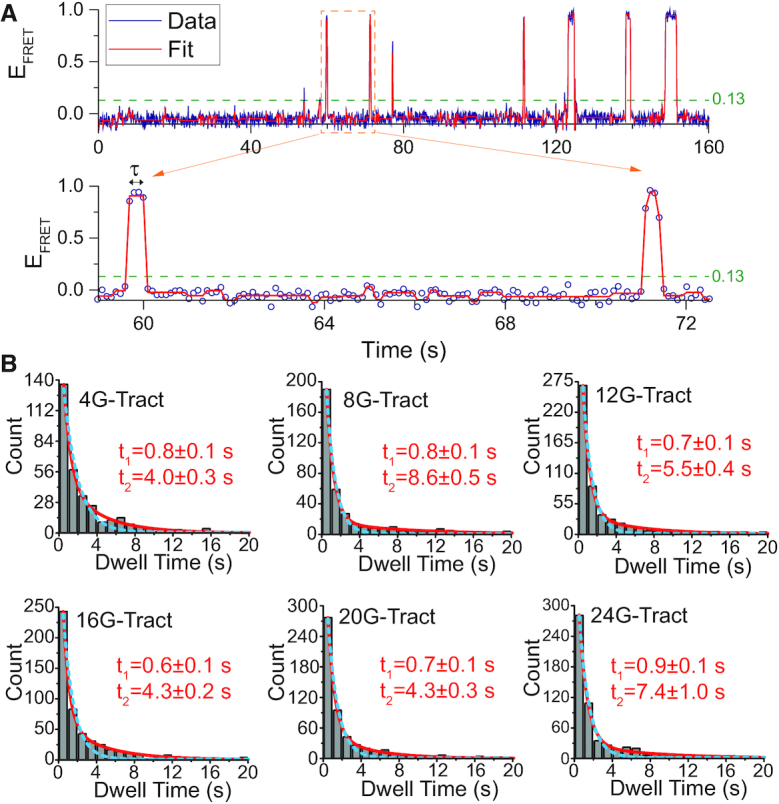
Determining the characteristic dwell times. (A) An example smFRET time trace that shows seven PNA binding events to a single telomeric overhang. A Stepfinder fit (red line) is used to characterize the FRET levels and dwell times (τ) of the binding events. The dashed line at EFRET = 0.13 represents the threshold level used for considering a FRET burst a PNA binding event, rather than noise. The signal bursts should also satisfy τ≥300 ms to be considered a binding event. (B) Distribution of dwell times determined from Stepfinder fit for each construct. The distributions were better described with a double exponential (red line) fit compared to a single exponential (dashed cyan line) fit, which consistently underestimated the counts of events with longer dwell times. In the double exponential, \documentclass[12pt]{minimal}
\usepackage{amsmath}
\usepackage{wasysym}
\usepackage{amsfonts}
\usepackage{amssymb}
\usepackage{amsbsy}
\usepackage{upgreek}
\usepackage{mathrsfs}
\setlength{\oddsidemargin}{-69pt}
\begin{document}
}{}${t_1}$\end{document} (faster decay) is the characteristic time for short dwells and \documentclass[12pt]{minimal}
\usepackage{amsmath}
\usepackage{wasysym}
\usepackage{amsfonts}
\usepackage{amssymb}
\usepackage{amsbsy}
\usepackage{upgreek}
\usepackage{mathrsfs}
\setlength{\oddsidemargin}{-69pt}
\begin{document}
}{}${t_2}$\end{document} (slower decay) is the characteristic time for long dwells. The number of binding events in the histograms for 4G-, 8G-, 12G-, 16G-, 20G- and 24G-Tract constructs is N = 331, 394, 561, 556, 563 and 604, respectively.